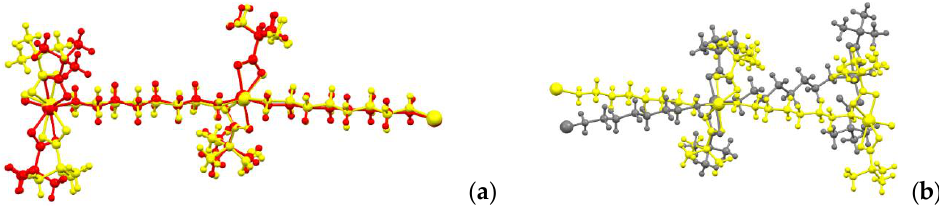
Figure 4. Geometry overlay of polymer chains 1 at different temperatures (( a ) —α - 1 (yellow) vs. β - 1 (red); ( b ) —α - 1 (yellow) vs. γ - 1 (grey)).